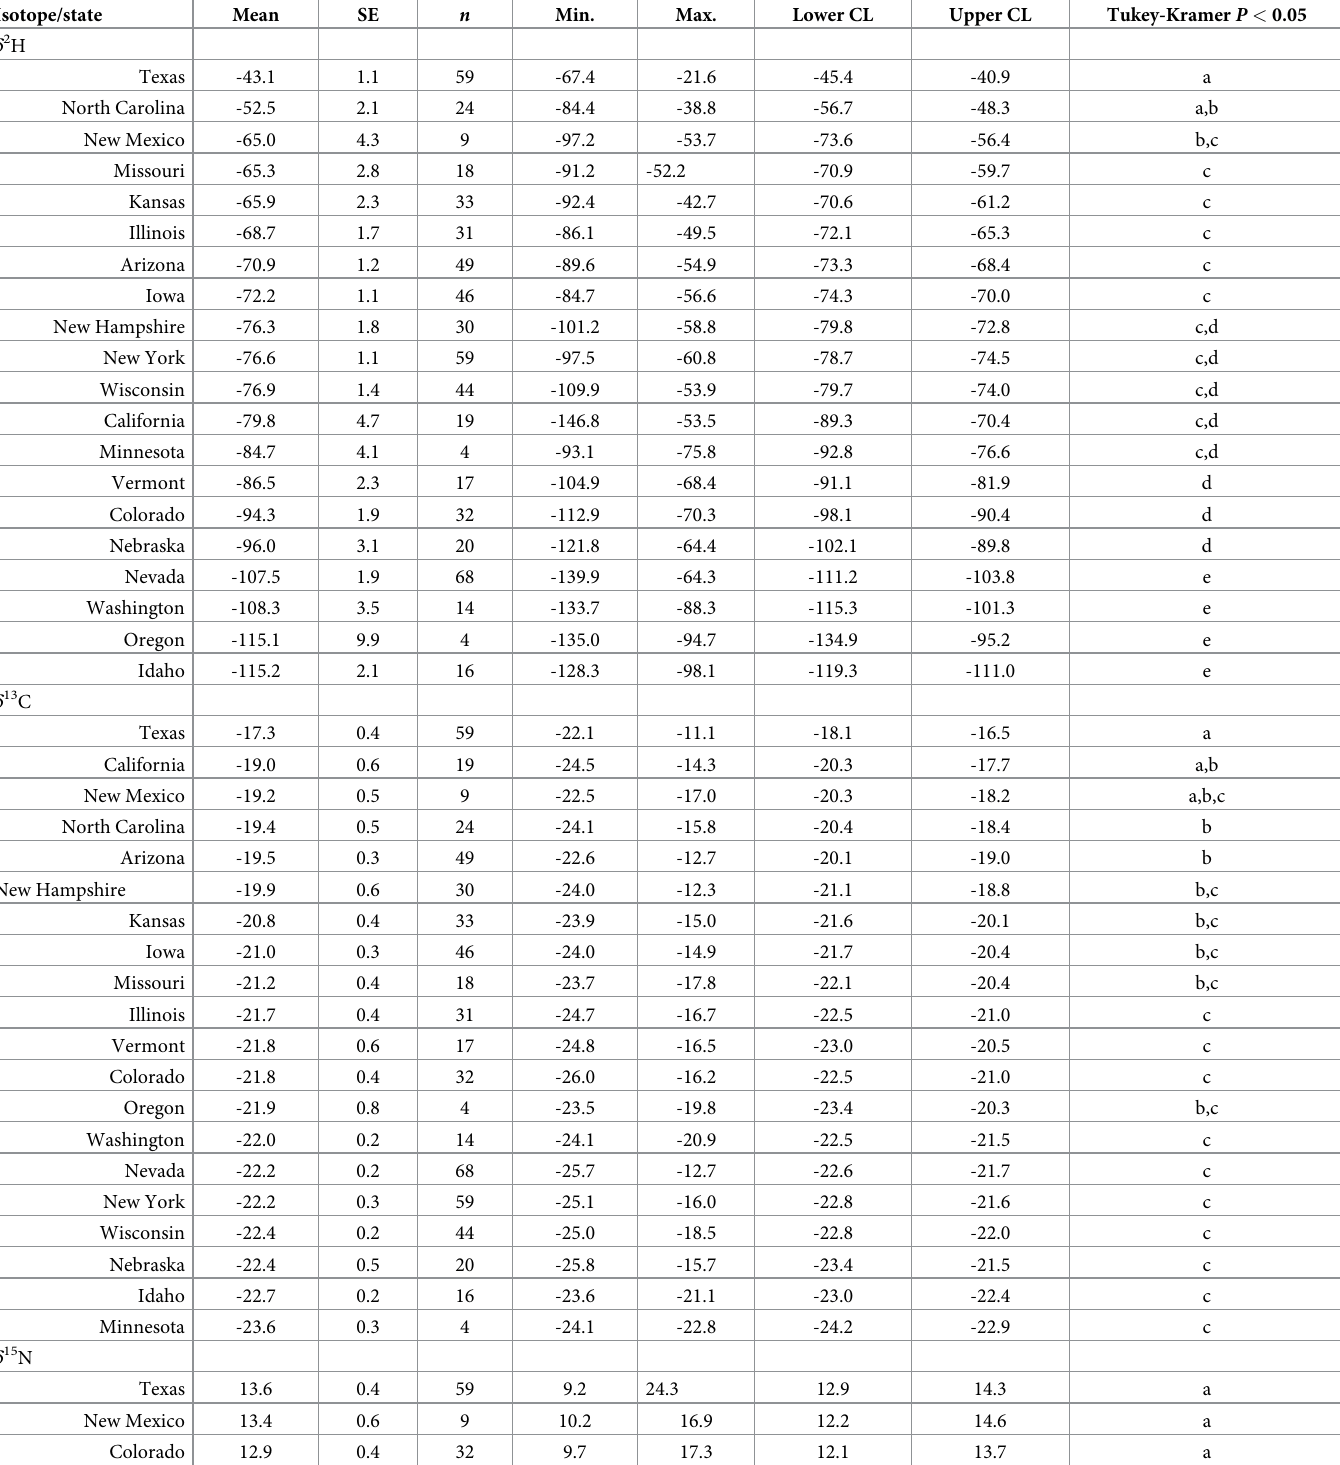
Table 3. Interstate comparisons of feather isotopes in 596 adult European starlings collected at U.S. dairies and feedlots. For each of δ 2 H, δ 13 C and δ 15 N, statistically different means between collection states are indicated by unique letters in the right column.